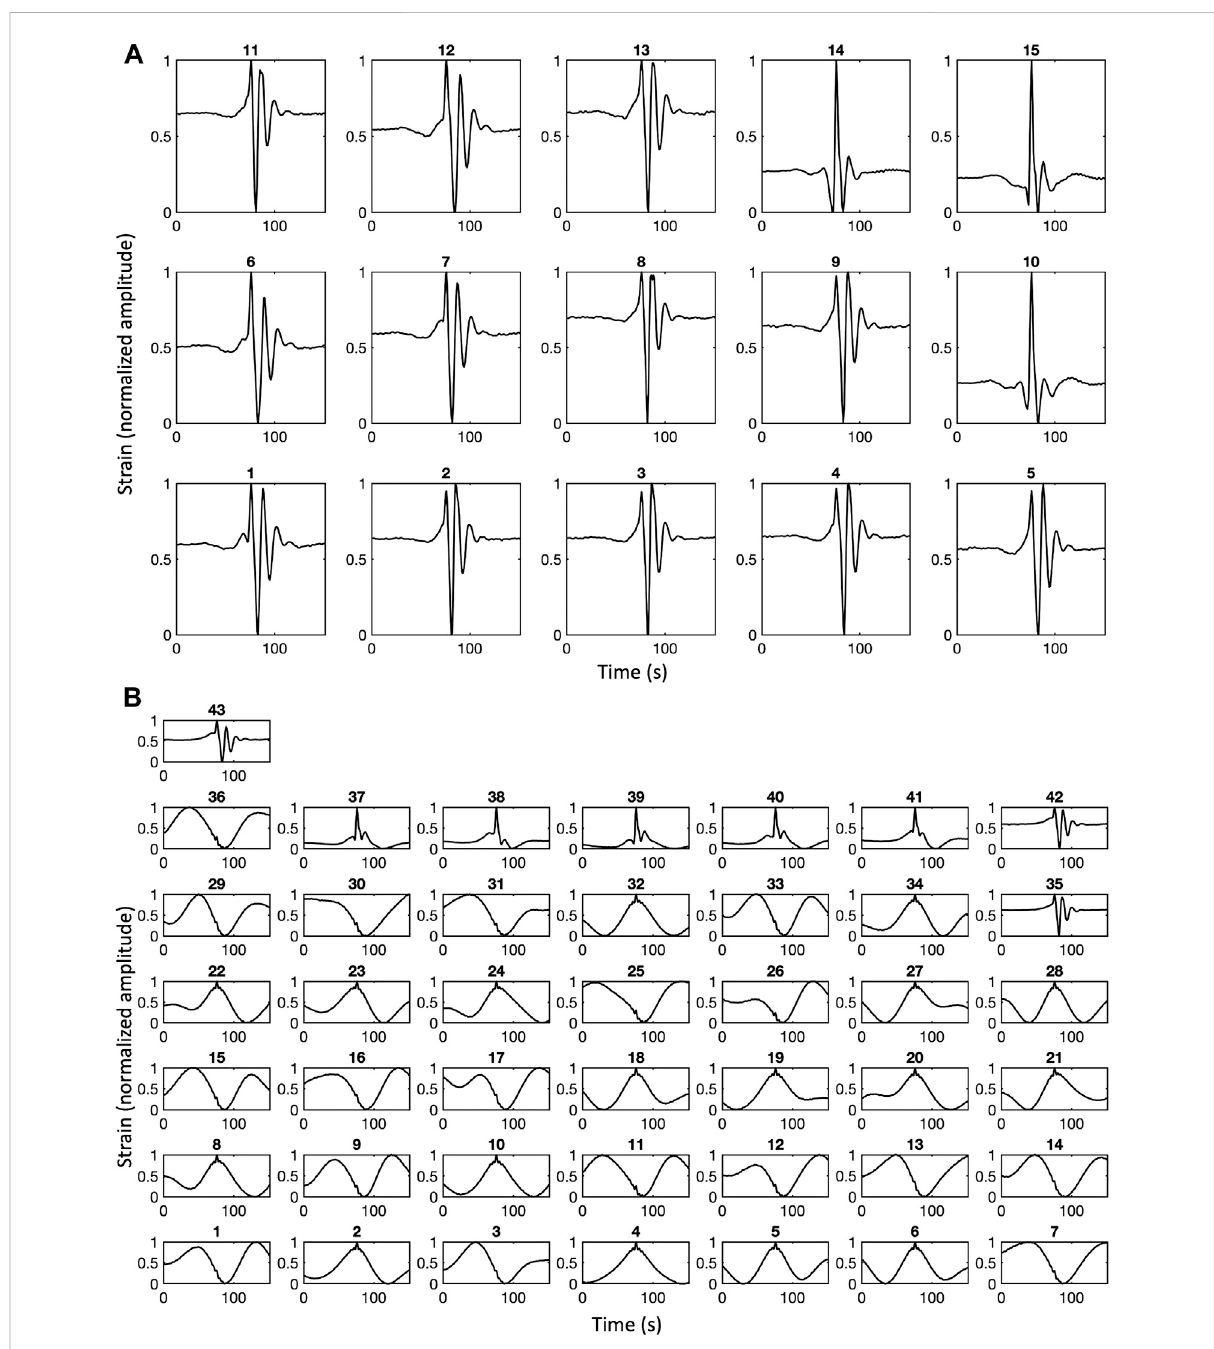
FIGURE 5 Normalized stacked waveforms belonging to the i th family determined by the CC algorithm (A) families found by the VLP iteration (B) families found by the ULP iteration. The horizontal axis indicates time in seconds.